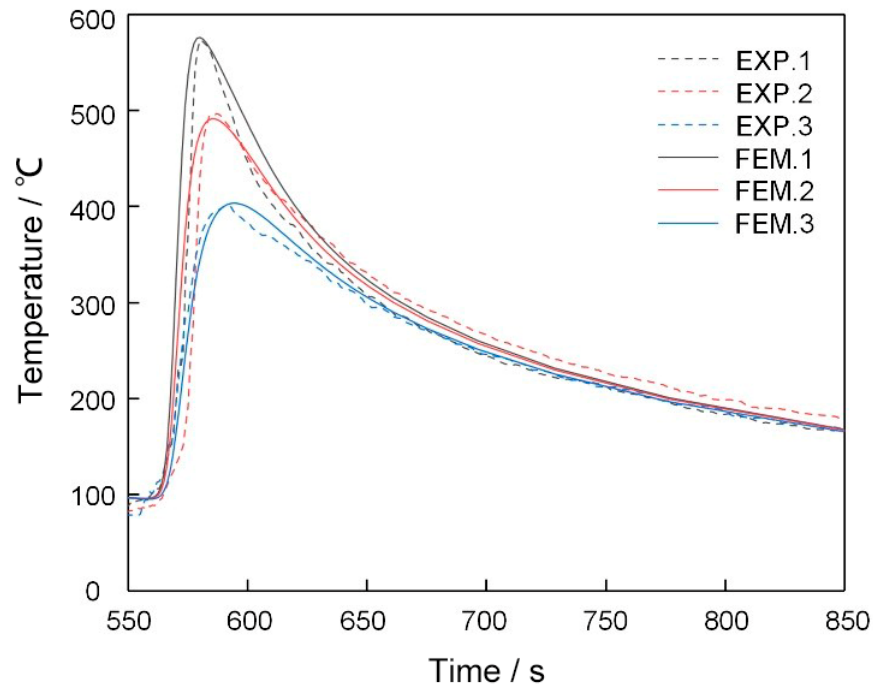
Figure 13. Simulation results and experimental results of welding thermal cycles. Figure 14. Peak temperature distribution along L2.